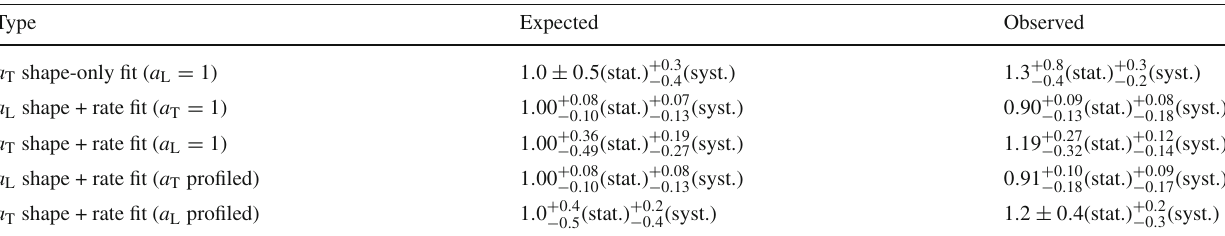
and κ VV are shown. Results of fits to one parameter with the other one fixed or profiled are